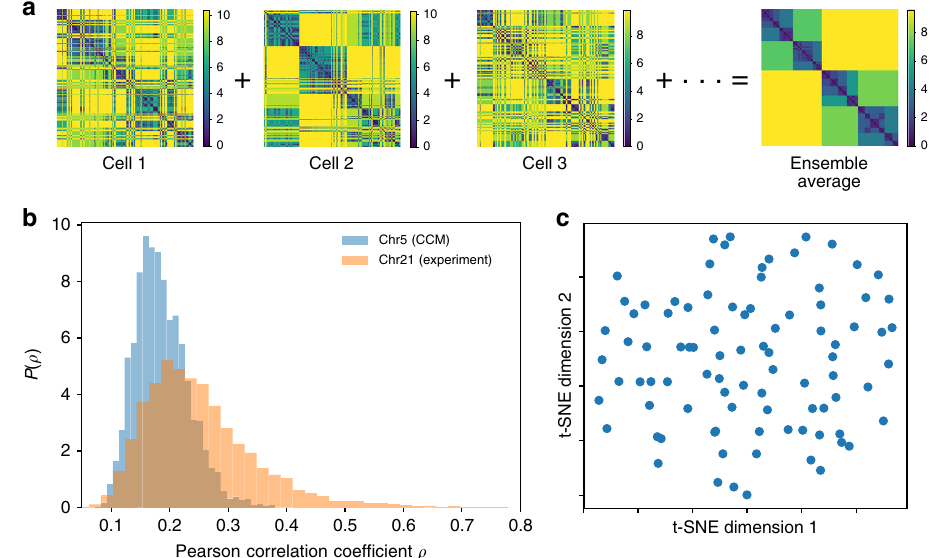
Fig. 5 Structural heterogeneity in the chromosome. a Ward linkage matrices of different individual cells. The single-cell WLM is the time average result over a single trajectory. The ensemble average WLM (rightmost) and the experimental WLM are in clear quantitative agreement (Fig. 4). However, the spatial organization show large variations from cell-to-cell. Each cell has very different WLM, implying their structures are distinct. b The distribution of ρ , P ( ρ ), with a mean (cid:1) ρ = 0.2 (blue curve), where ρ is the Pearson correlation coef fi cient between WLMs of any two cells. The P ( ρ ) distribution, spanning the low range of ρ values, is a further demonstration of structural heterogeneity in individual cells. In yellow we plot P ( ρ ) with (cid:1) ρ = 0.25 for 120 individual human interphase Chr 21, computed using the single-cell WLMs constructed from experimental measured spatial distance data provided in ref. 6 c Two- dimensional t-SNE (t-distributed stochastic neighboring embedding) visualizations of WLM of simulated individual Chr 5 using the distance metric